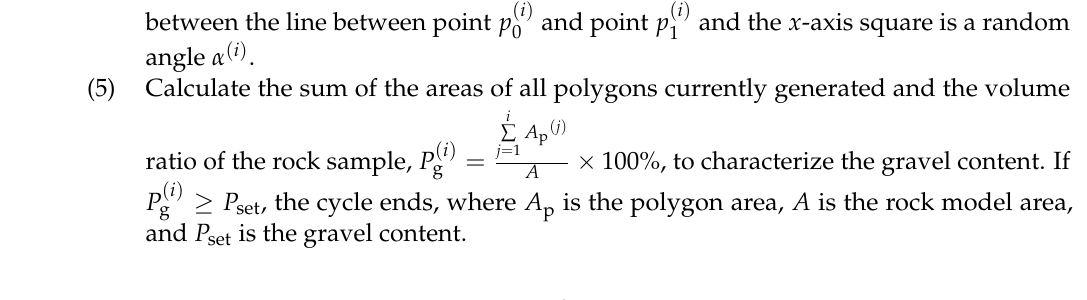
Table 1. Comparison of mechanical parameters between the rock samples and the DEM rock model.